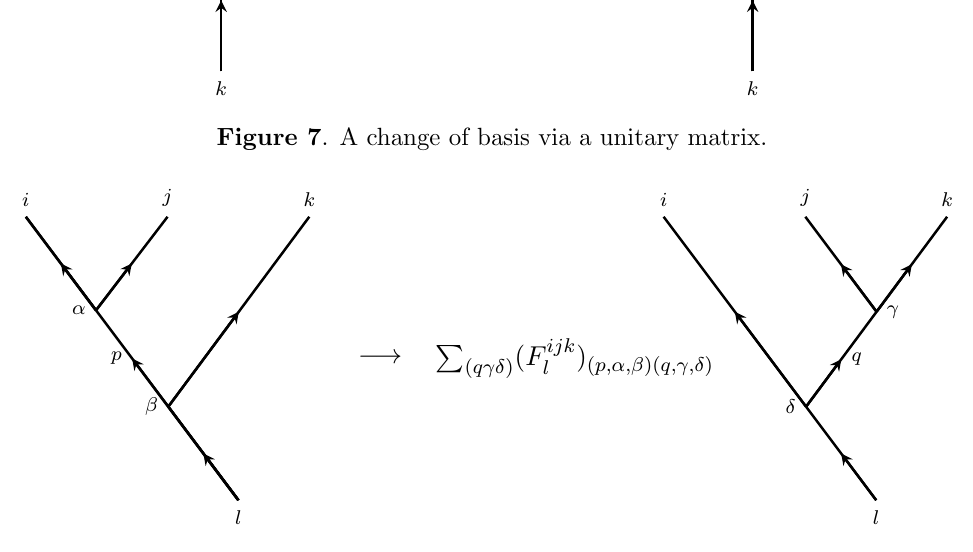
Figure 8 . De(cid:12)nition of F